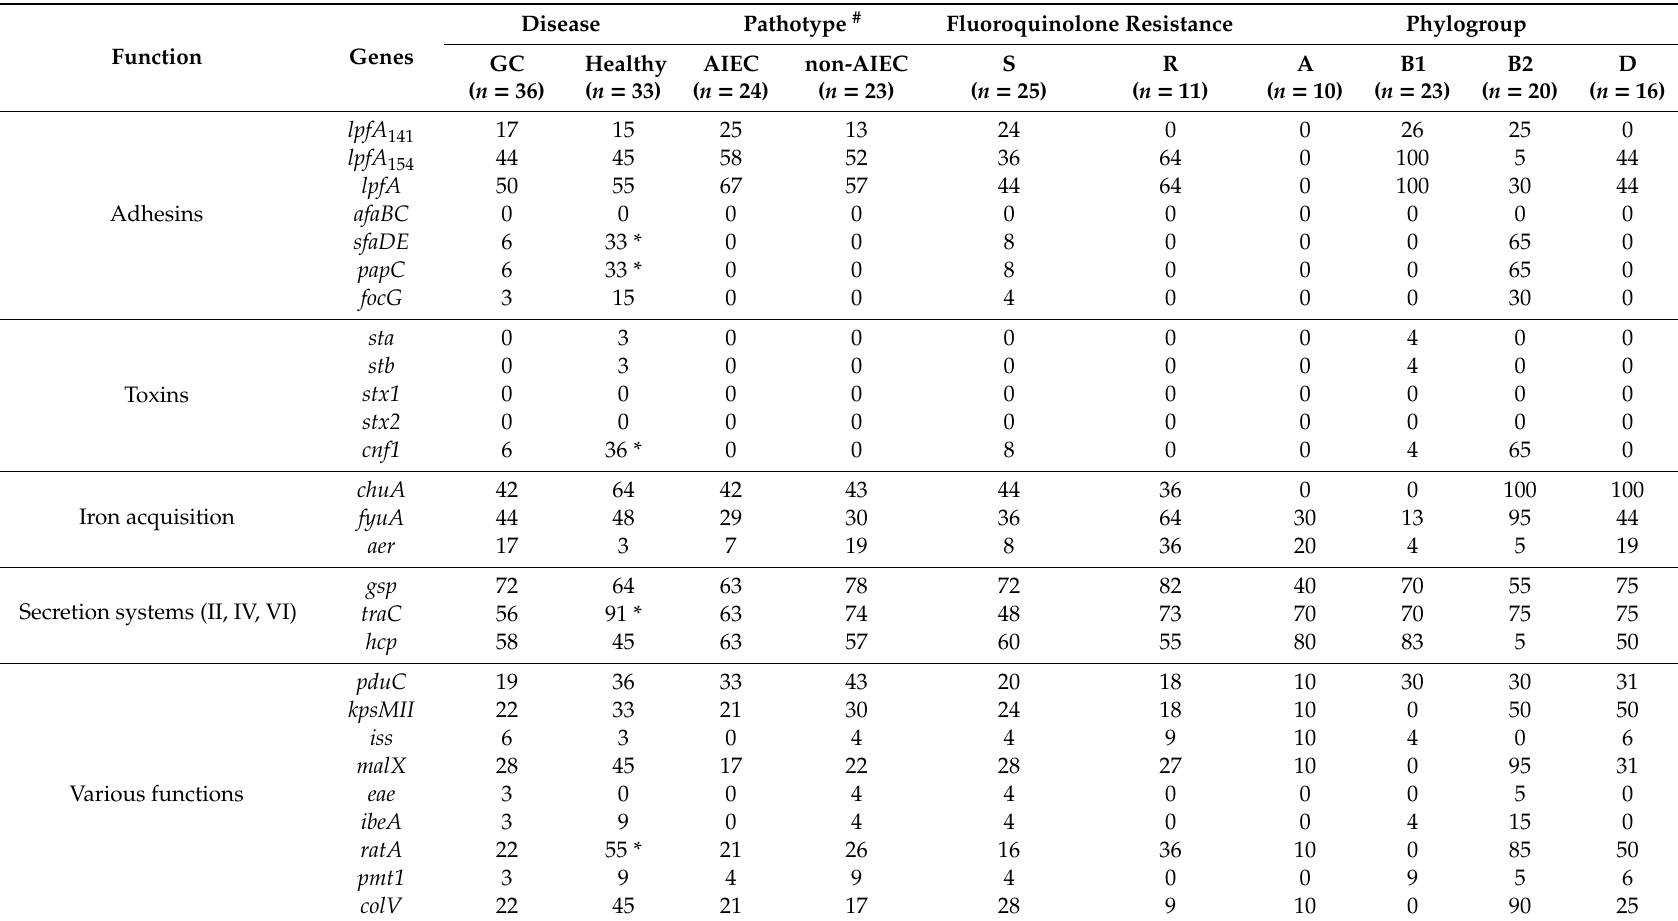
Table 1. Prevalence of virulence genes in E. coli strains isolated from dogs with GC and